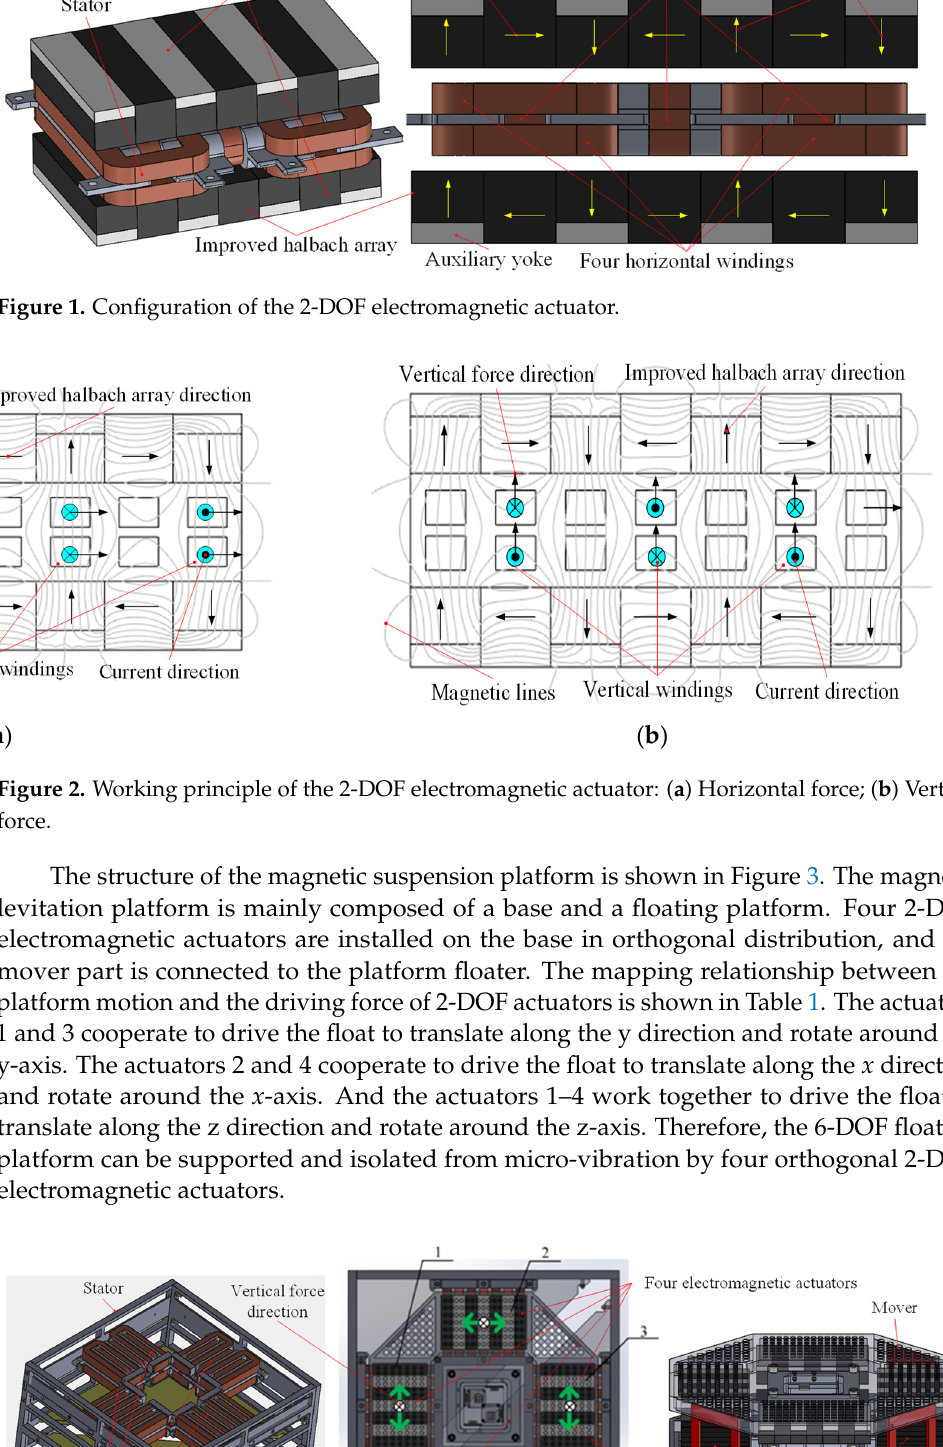
Figure 3. Structure and working principle of the magnetic suspension platform.